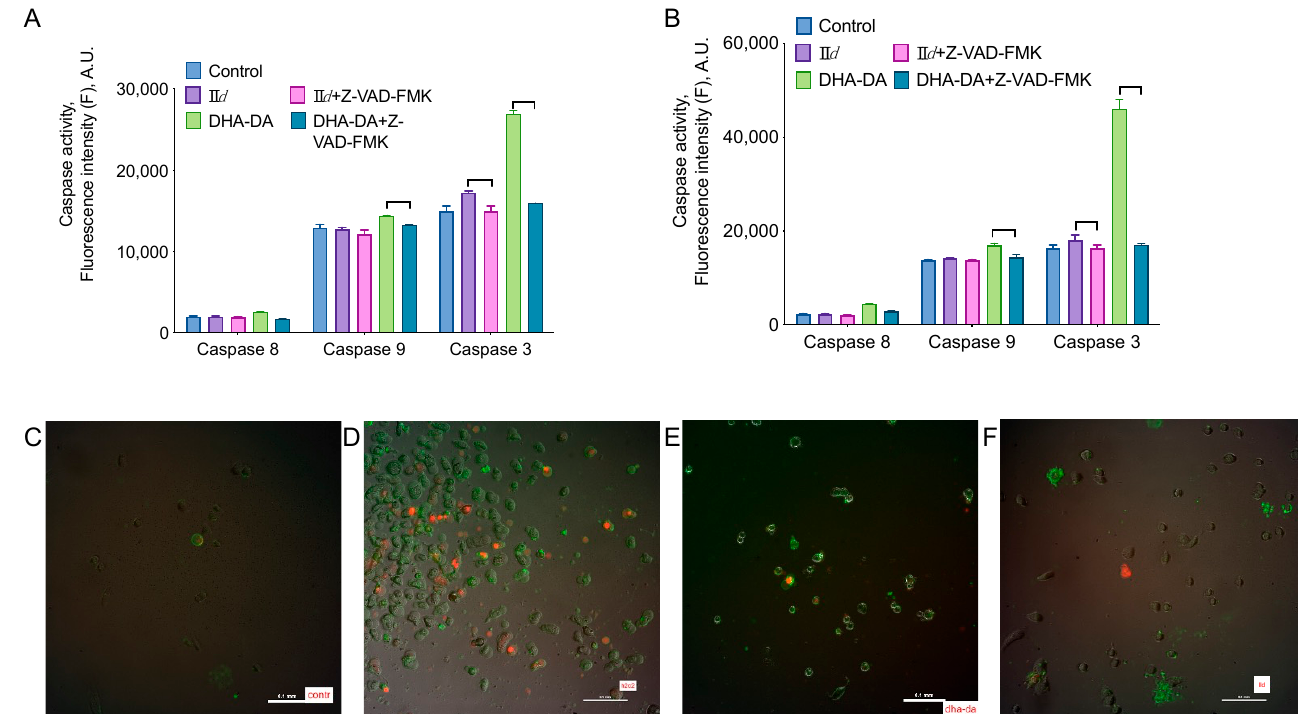
Figure 6. Apoptosis induction by the II d compound for the MDA-MB-231 cell line. Caspases activity after 5 ( A ) and 2 ( B ) h of incubation with 100 µM of GT-04 or 90 µM of apoptosis inductor (N-docosahexaenoyl dopamine, DHA-DA) with or without 80 µM of Z-VAD-FMK. amalgamated data of n = 3 experiments. Membrane integrity loss (DNA-binding dye propidium iodide, red) and phosphatidylserine externalization (annexin-FITC dye, green) in the control cells ( C ) and after the treatment with 5 mM of H 2 O 2 ( D ), 80 µM of DHA-DA ( E ) or 100 µM of II d ( F ).